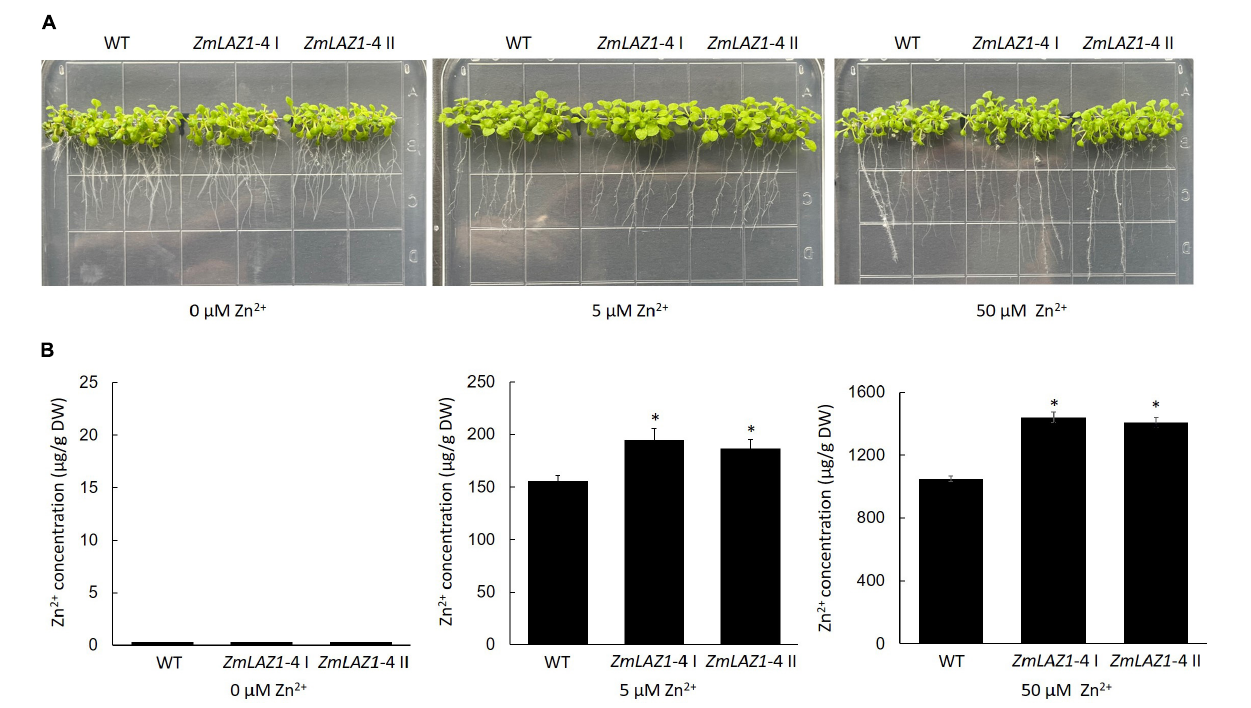
FIGURE 3 | Phenotype and Zn 2 + content of transgenic Arabidopsis . (A) Phenotype. (B) Zn 2 + content. The seeds of every line were sterilized and grown on 1/2 MS zinc deficiency plates (control) with 5 and 50 µ M ZnSO 4 for 2 weeks, respectively. WT, wild type. ZmLA1-4 I and ZmLA1-4 II represent homozygous lines. ∗ p < 0.05.